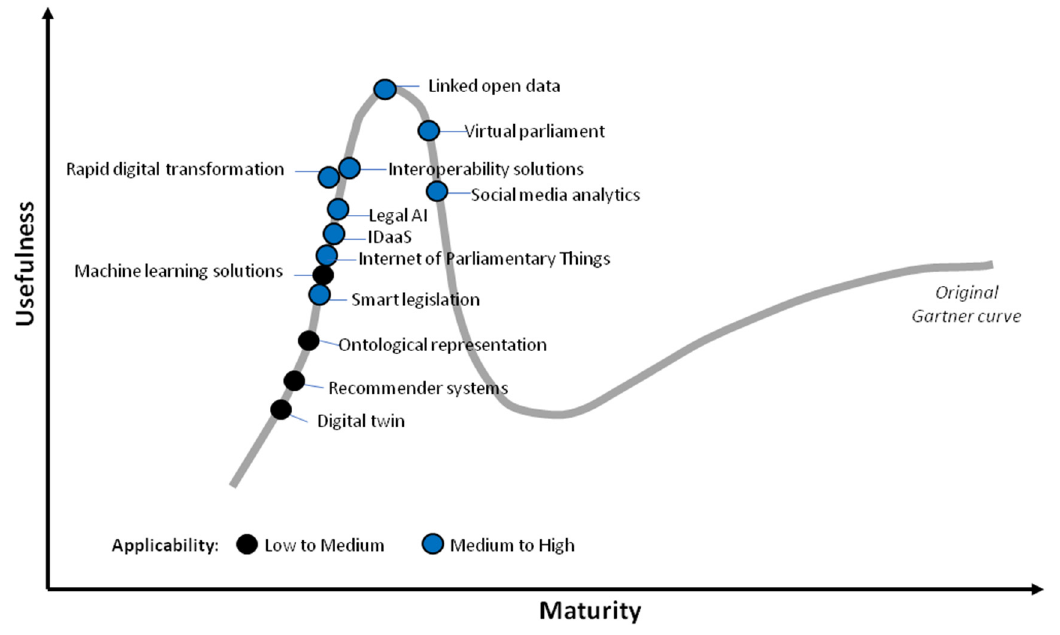
Figure 1. ParlTech hype cycle for year 2020.